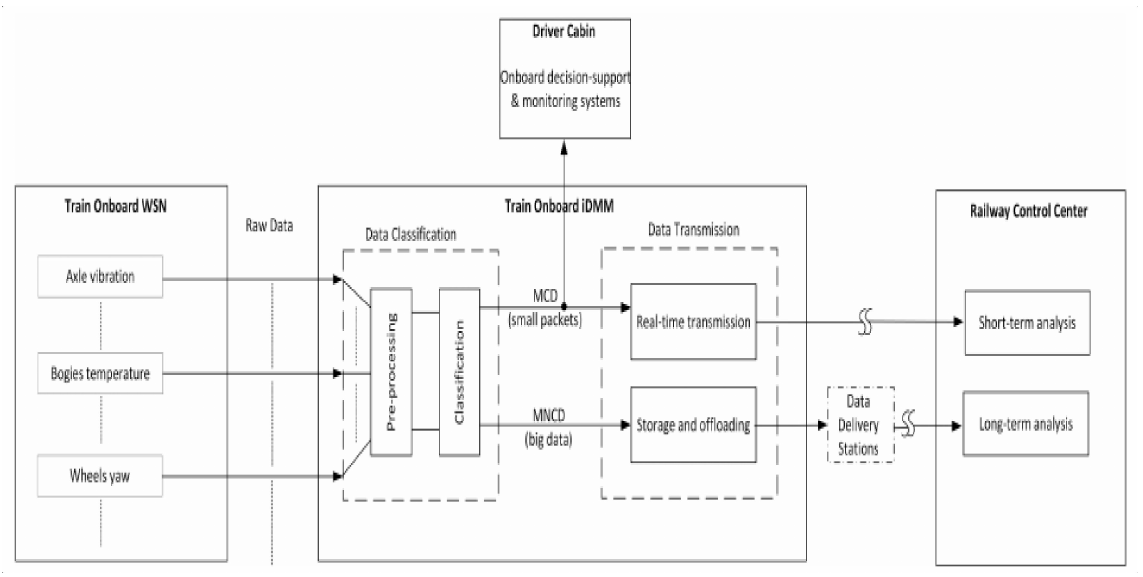
Figure 21. Big data classification and transportation in rail networks